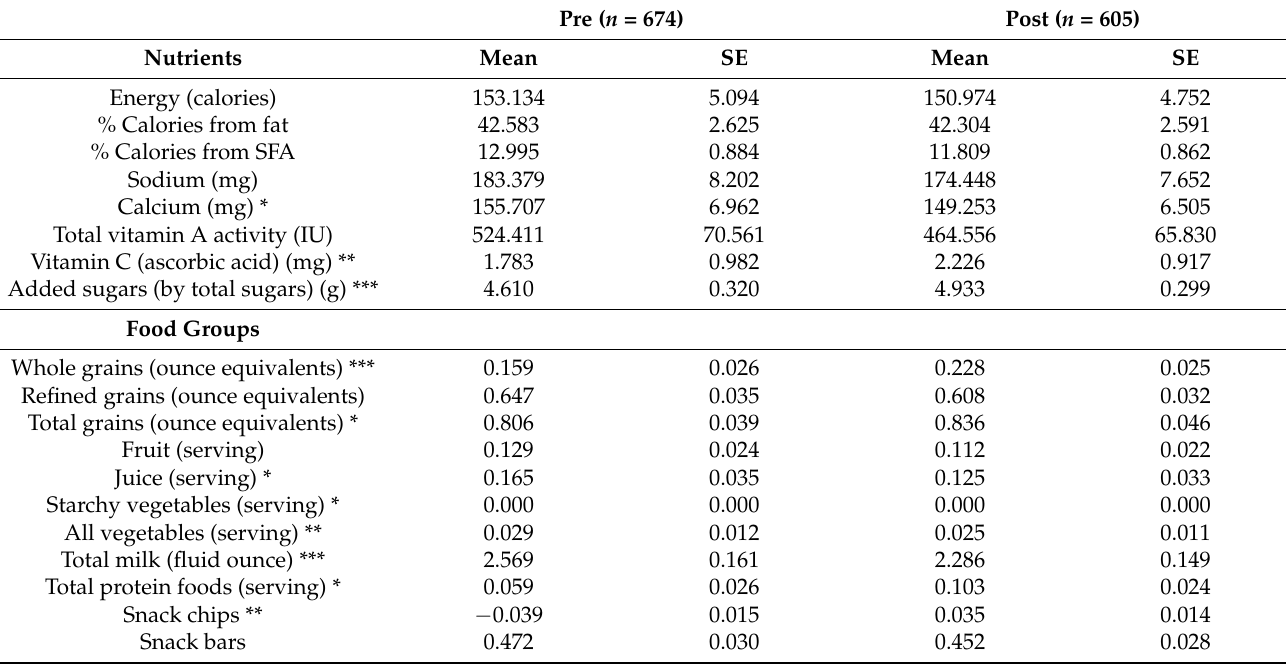
Table 4. Adjusted means of nutrients and food groups consumption at